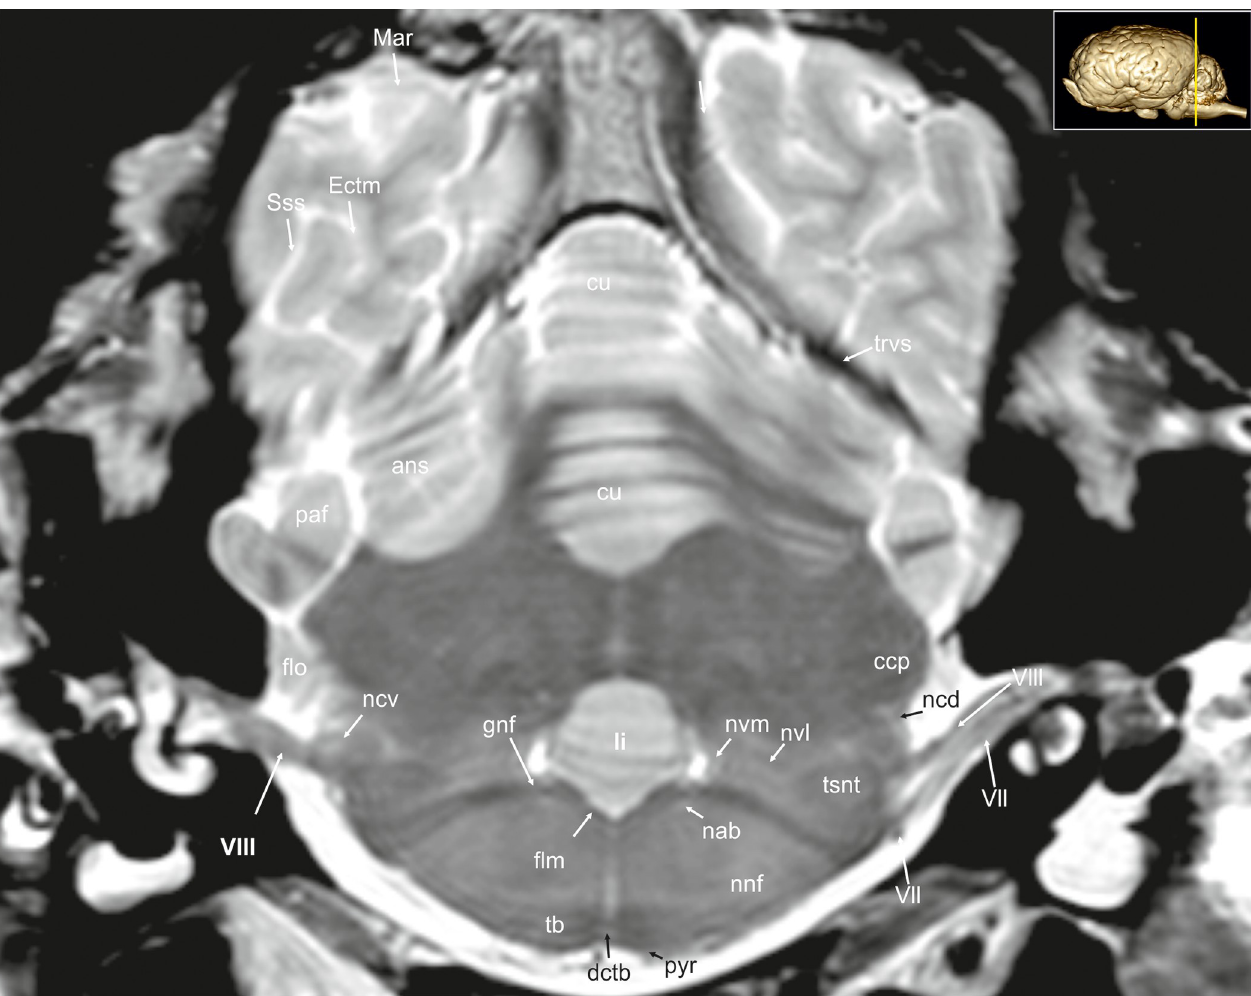
Fig 13. Transverse magnetic resonance image of the equine brain on the level of the genu of the facial nerve. ans: ansiform lobule, ccp: caudal cerebellar peduncle, cu: culmen, Ectm: ectomarginal sulcus, flm: medial longitudinal fasciculus, flo: flocculus, gnf: genu of the facial nerve, li: lingula of the vermis, Mar: marginal sulcus, nab: nucleus of the abducent nerve, ncd: dorsal cochlear nucleus, ncv: ventral cochlear nucleus, ndct: superior olivary nucleus, nvl: lateral vestibular nuclei, nvm: medial vestibular nucleus, paf: paraflocculus, pyr: pyramidal tract, rst: rubro-spinal tract, Sss: suprasylvian sulcus, tb: trapezoid body, trvs: transverse sinus, tsnt: spinal tract of the trigeminal nerve, qdr: quadrangular lobe, VII: facial nerve, VIII: vestibulocochleal nerve.